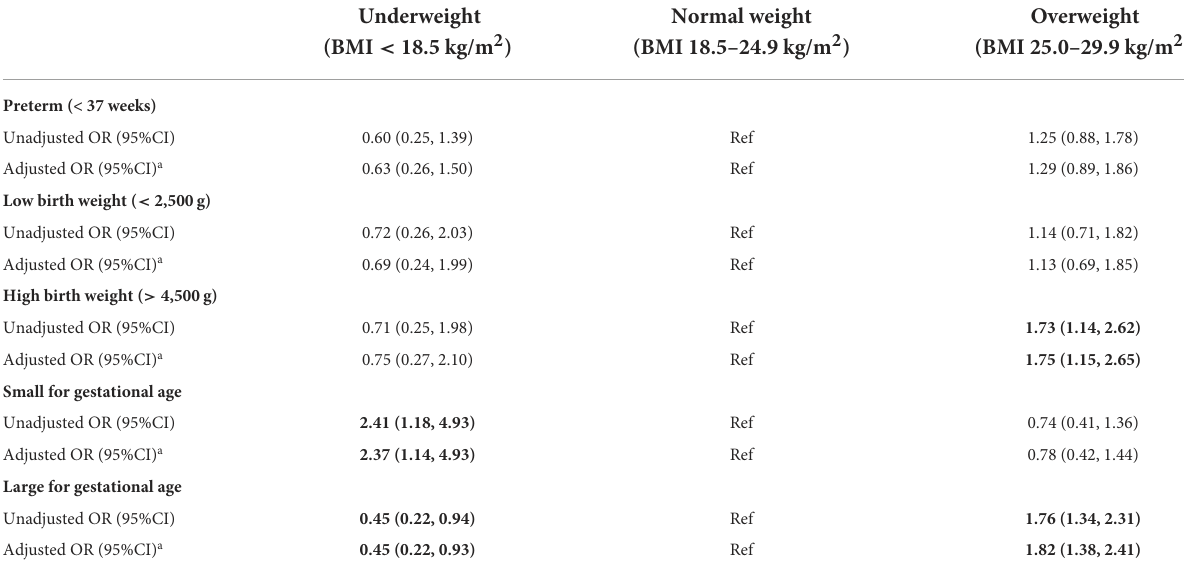
TABLE 3 ORs (95%CI) for the relationship of pre-pregnancy BMI with neonatal outcomes among women with PCOS following frozen-thawed embryo transfers.